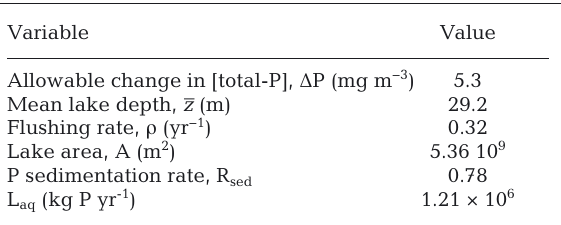
Table 6. Calculation of the sedimentation rate (R sed ) from annual total-P fluxes in Lake Kariba (P zam , P sec, P out KaribaFlow Table 7. Estimation of the total allowable aquaculture P load (L aq ) into Lake